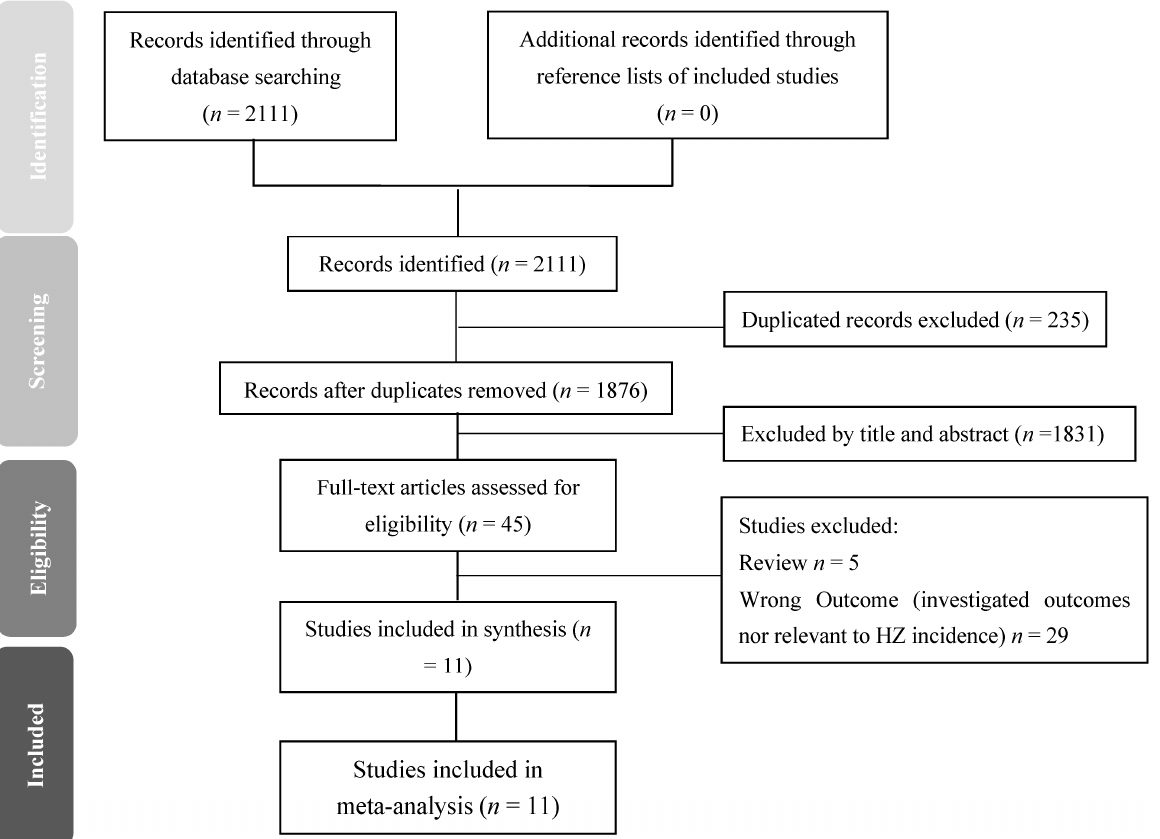
Figure 1. Preferred reporting items for systematic review and meta-analyses (PRISMA) flow diagram for searching and identifying included studies. Database: PubMed ( n = 221), Embase ( n = 1793), Cochrane Library ( n = 23) and CINAHL ( n = 74). Keywords: (Human Immunodeficiency Virus OR Acquired Immune Deficiency Syndrome Virus* OR Lymphadenopathy-Associated Virus*) AND (HAART OR ART OR Antiretroviral Therapy*) AND (Incidence OR Herpes Zoster OR Varicella Zoster Virus* OR herpes virus infection). Date: available until 28 February 2021.